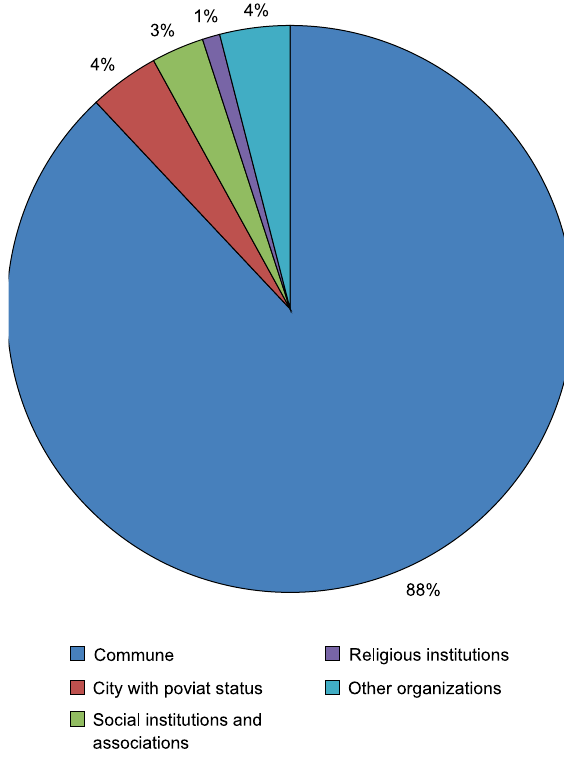
Fig. 3. Structure of pupils in primary schools in Poznań agglomeration by school-running authority